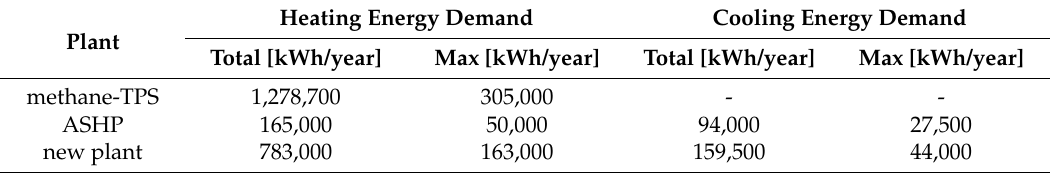
Figure 5. Energy demand evaluated by Design Builder software tool. The heating energy needs are reported as positive values, while the cooling ones are considered negatives. Table 9. Energy demands through the year for heating and cooling referred to each plant.